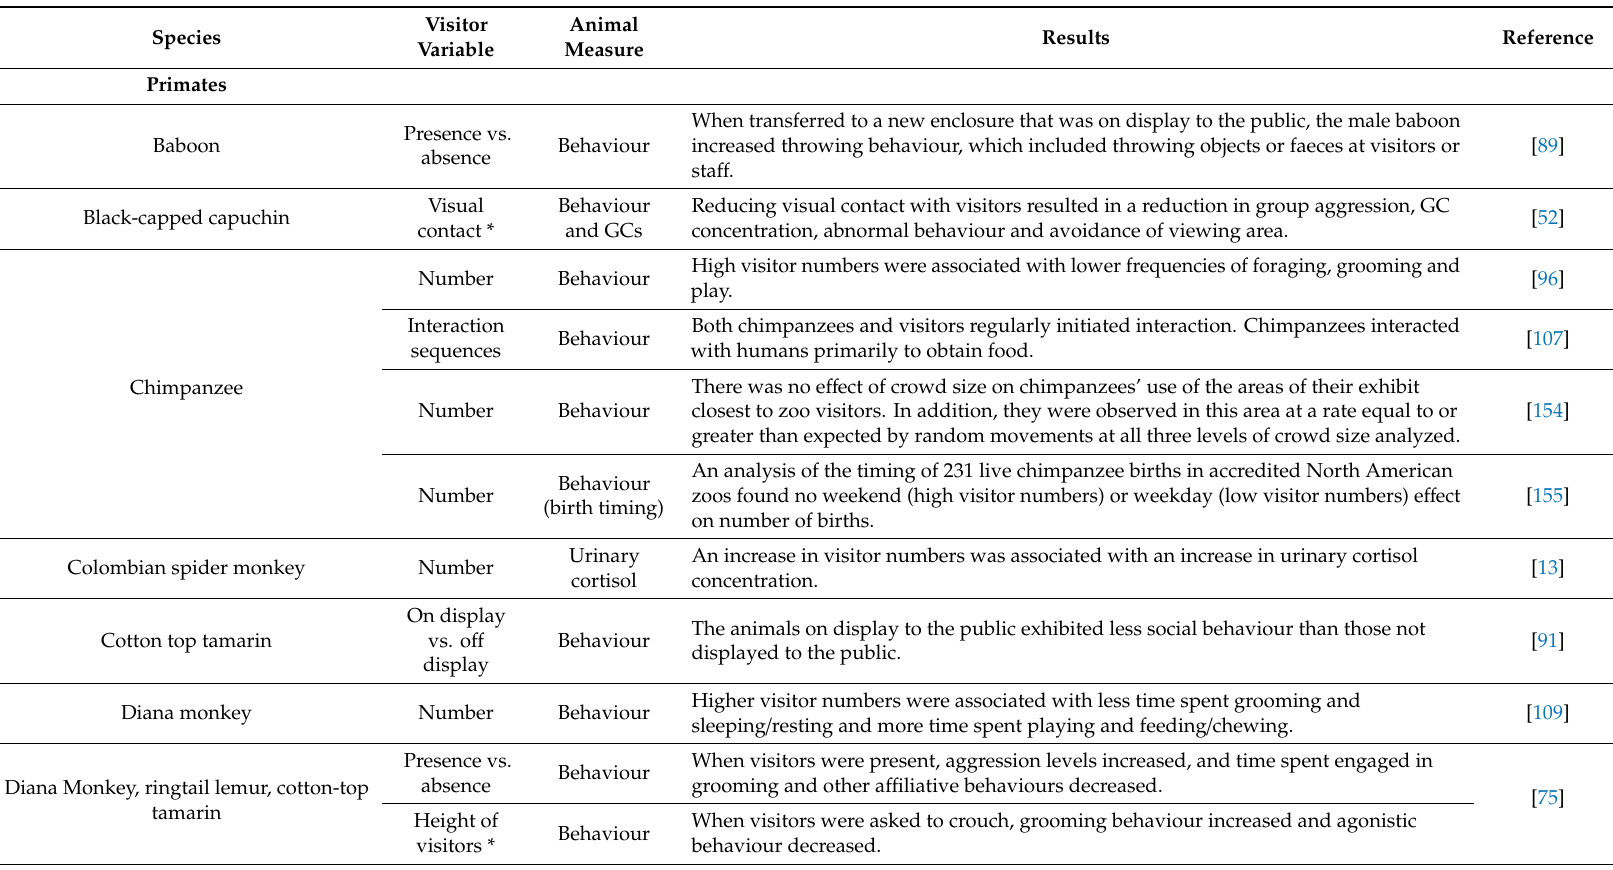
Table A1. A summary of the majority of studies published in peer-reviewed journals conducted on the visitor e ff ect highlighting the visitor variables studied, the animal measures used and the main results. * represents studies that involved some form of experimental manipulation. GC,